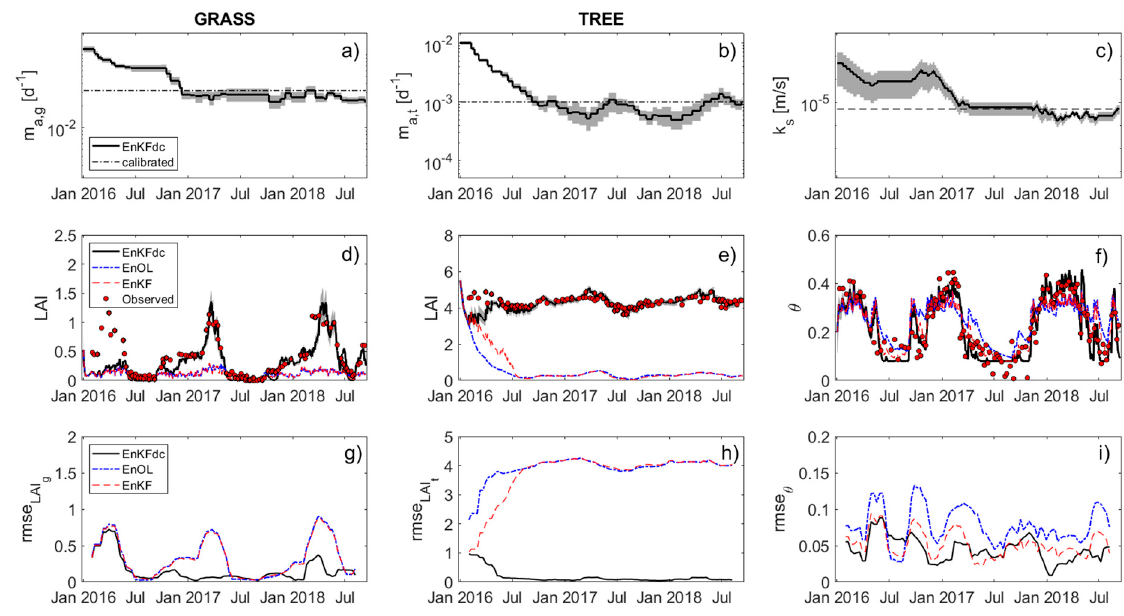
Figure 3. Assimilation results for soil moisture, grass, and tree LAI predictions at the Sardinian site using initial high ˆ k s , ˆ m a , g (for grass), and ˆ m a , t (for trees) values of 5 × 10 − 4 m/s, 0.12 d − 1 , and 0.01 d − 1 , respectively: ( a – c ) show the evolutions of the k ζ s , m ζ a , g , and m ζ ensembles, respectively, using the EnKFdc approach (the means of the ensembles are in black thick lines; for reference, the calibrated values of k s , m a,g , and m a,t are reported in dotted horizontal lines); ( d – f ) show the comparison between LAI and soil moisture observations derived from assimilated remote data (obs.) and the ensemble means predicted using the EnOL, EnKF, and EnKFdc approaches, respectively; ( g – i ) show the evolutions of the RMSE of the ensemble mean of soil moisture and LAI predicted using the EnOL, EnKF, and EnKFdc approaches concerning the observed soil moisture and LAI (derived from remote sensing data) using a 60-day window, translated in 10-day increments.